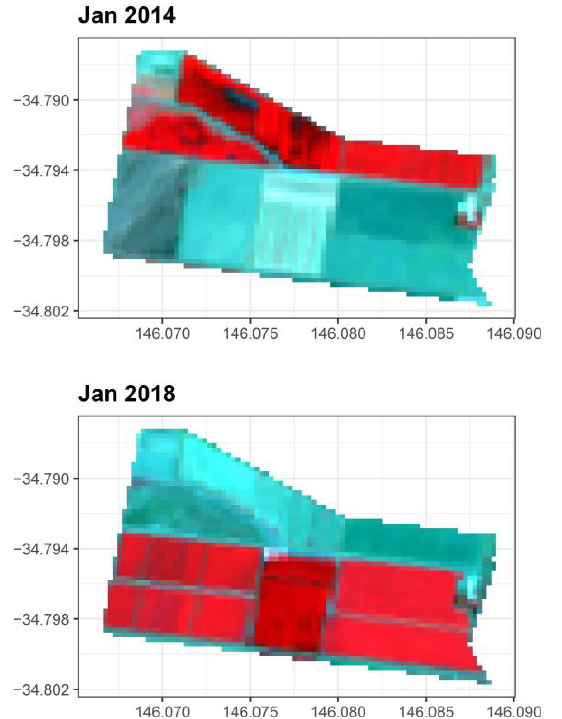
Figure 12. The change in field boundaries shown by Landsat 8 false-color composite (band 5-4-3) in